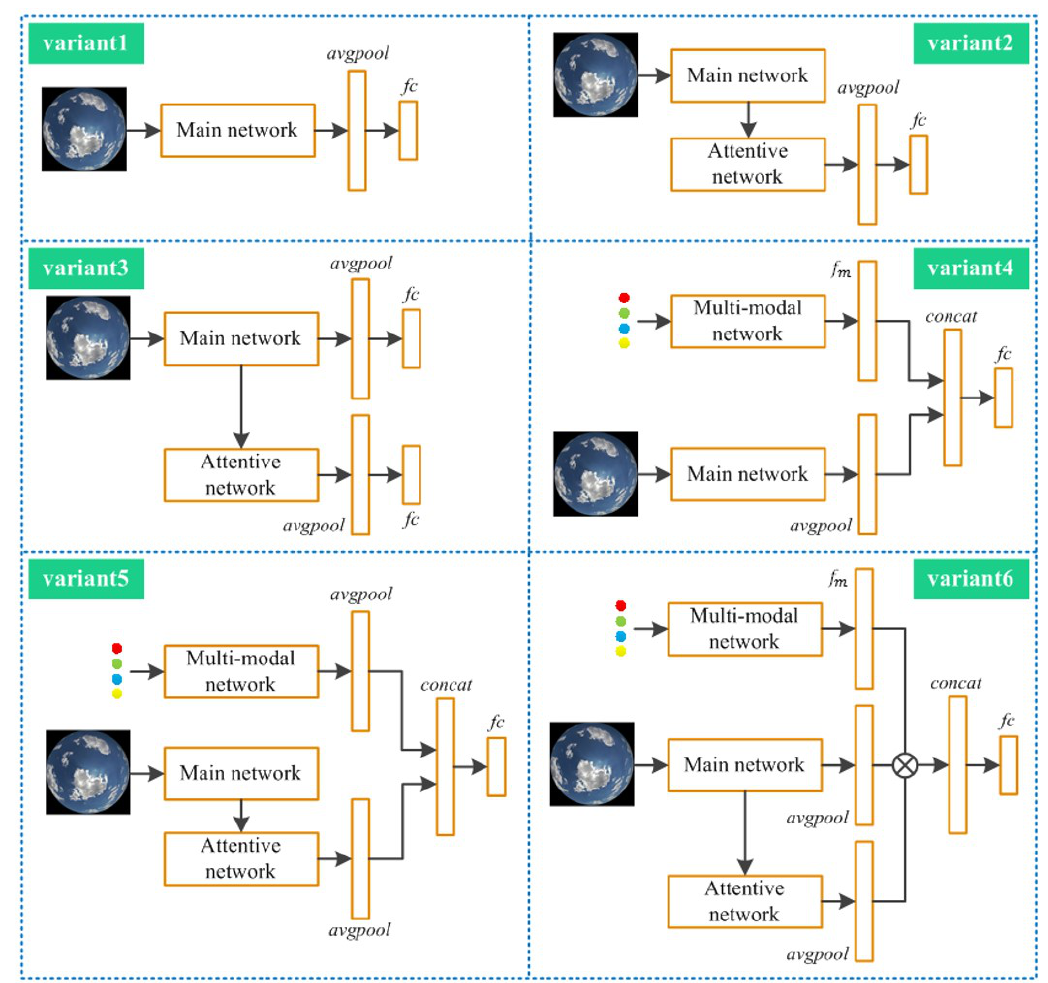
Figure 6. The sketches of variant1 ∼